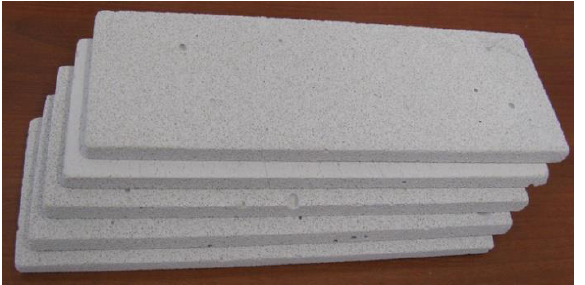
Figure 4. Set of aerated concrete samples used for the experiment.